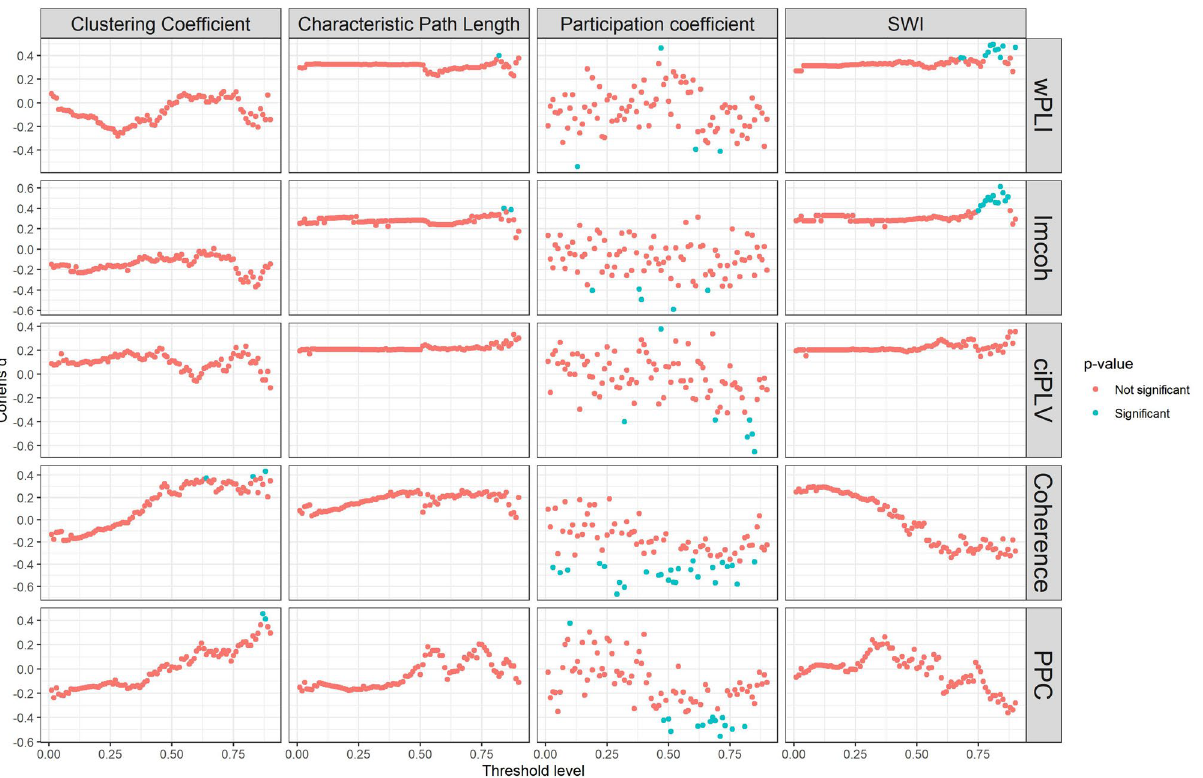
Figure 10. The Cohen’s d of the gender comparison on the different thresholds in source space. A permutation t-test was used to estimate the differences between two groups. The blue dots represent the effect as significant (p-value < 0.05), the red represents the non-significant effect (p-value > 0.05). ggplot2 3.3.6 (https:// ggplo t2. tidyv erse. org/) was used to create this